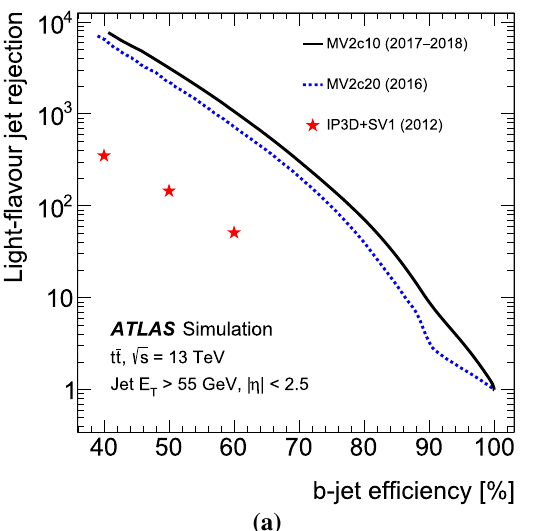
(used during 2016). The performance of the b -jet trigger during Run 1 (stars) is also shown in terms of its light-flavour jet rejection